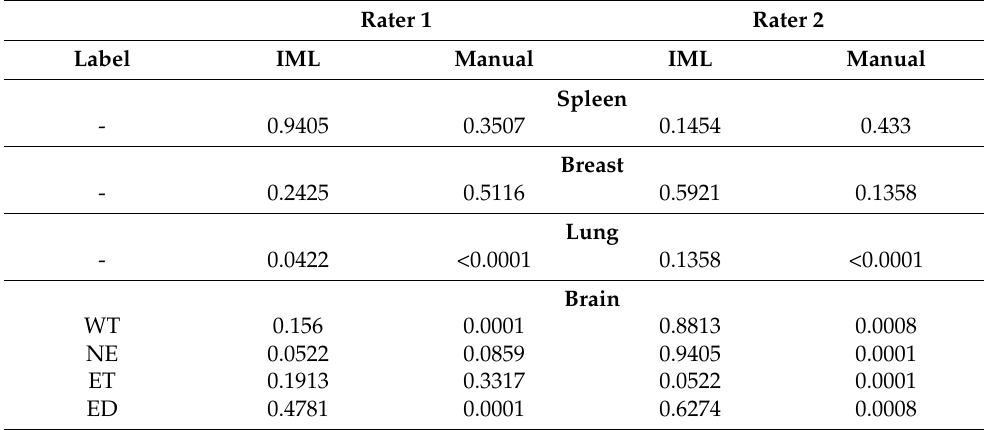
Table 2. Results ( p -values) of a paired Wilcoxon test for each rater, comparing the dice coefficient results of the different approaches relative to ground. p < 0.05 indicates a significant